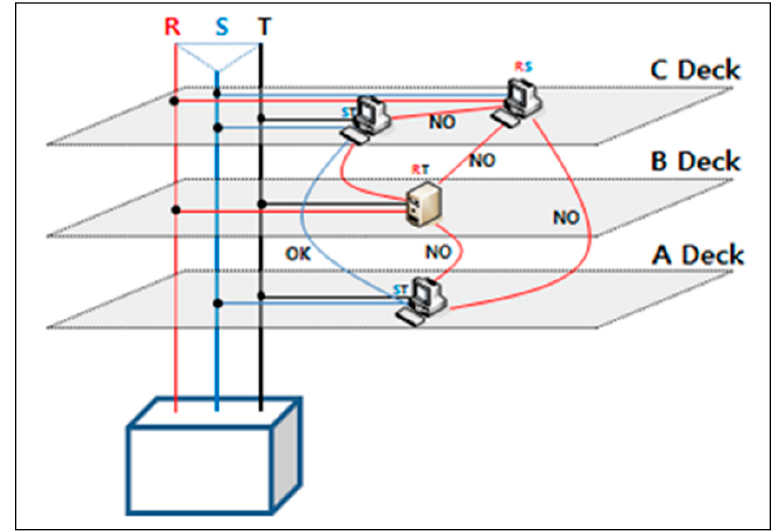
Figure 9. Outside communication network problem.